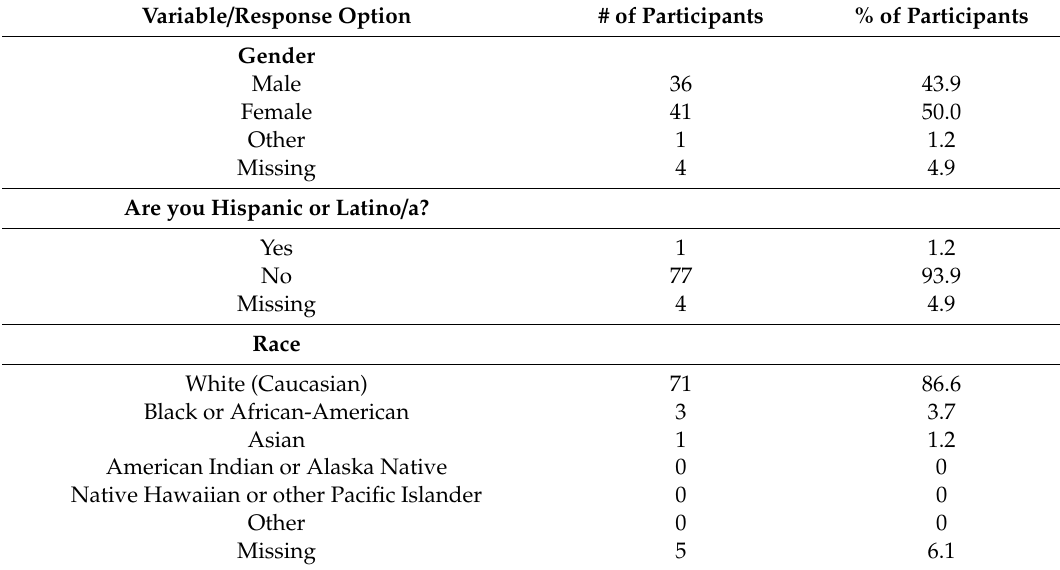
Table A1. Study Participants’ Demographic